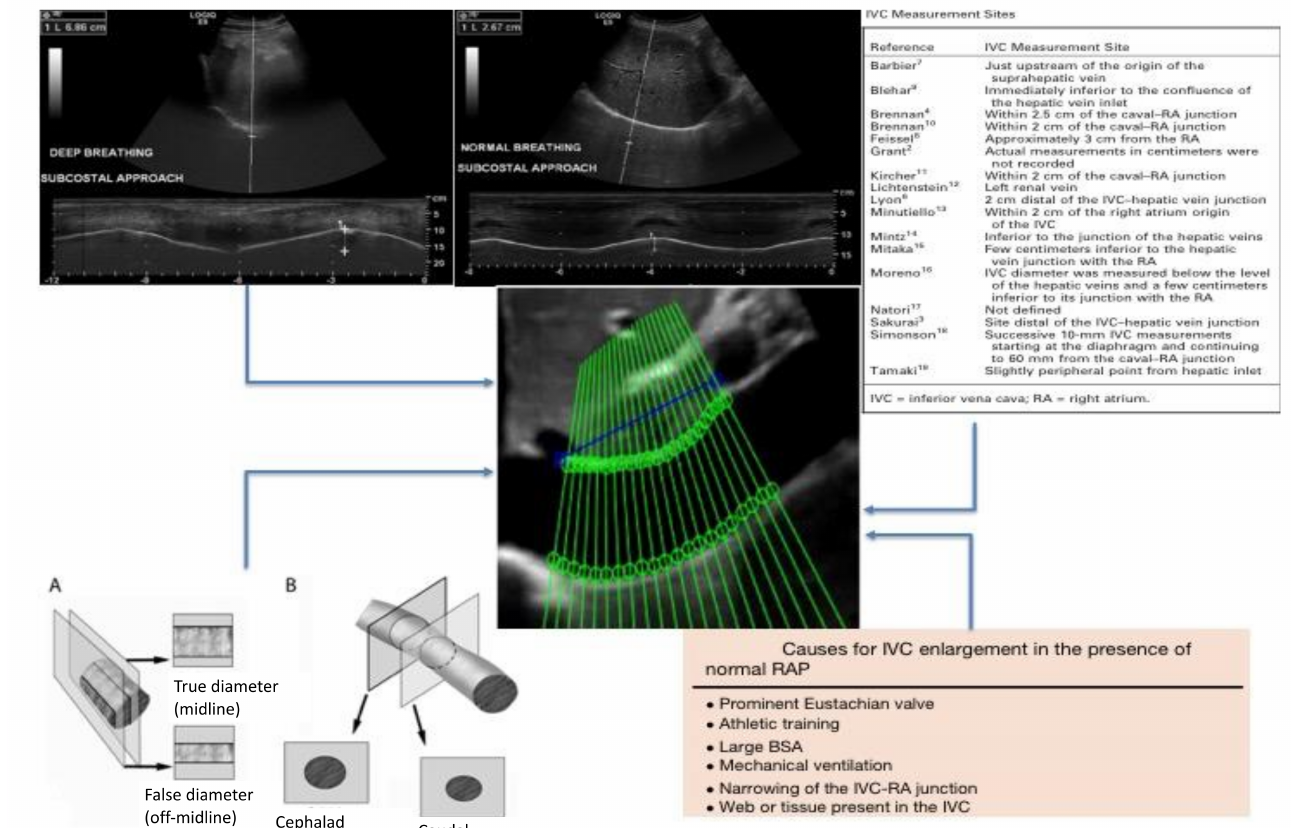
Figure 2. Critical issues on RAP estimation by using IVC diameters. Top left : different breathing man- ners studied with US M-mode of the diaphragm. Top right : different proposed sites of measurement of the IVC. Bottom left : effect of the vein movement on the IVC diameter measurement showing foreshortening of the vein due to the respiratory cycle (A: latero-lateral displacement, B: cranio- caudal displacement) [12]. Bottom right : causes of unreliability of the IVC in RAP estimation [2]. Center: the proposed new IVC edge-to-edge tracking technique (adapted from Blehar et al. [12] and Wallace et al.